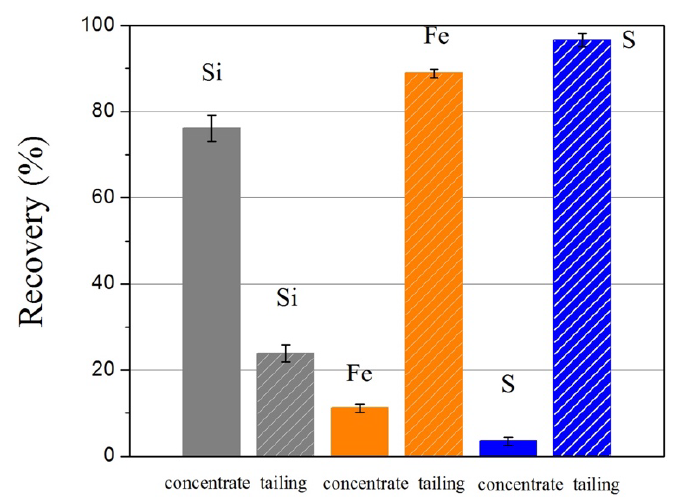
Figure 5. Recovery of Si, Fe, and S for the concentrated flotation samples.